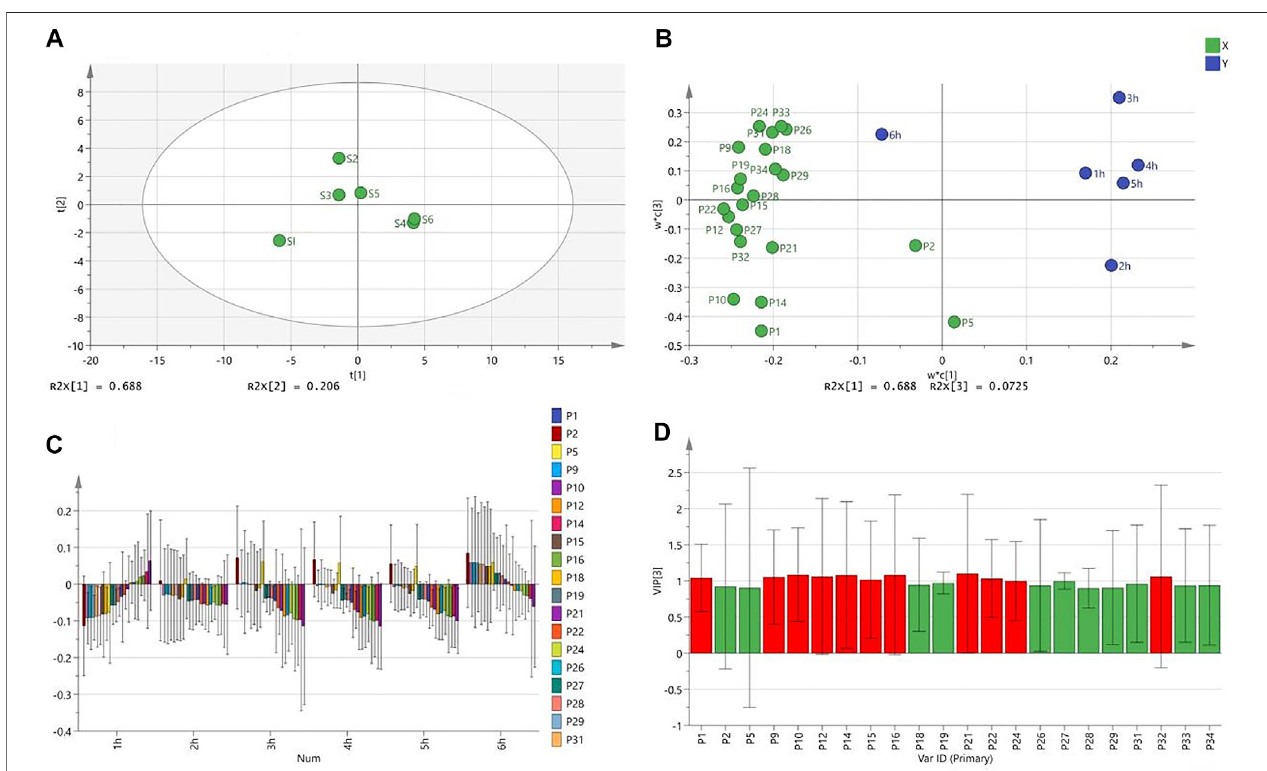
FIGURE 4 | OPLS analysis results [ (A) Score scatter Plot; (B) Loading Scatter Plot; (C) Coef fi cient overview Plot; (D) VIP value graph].